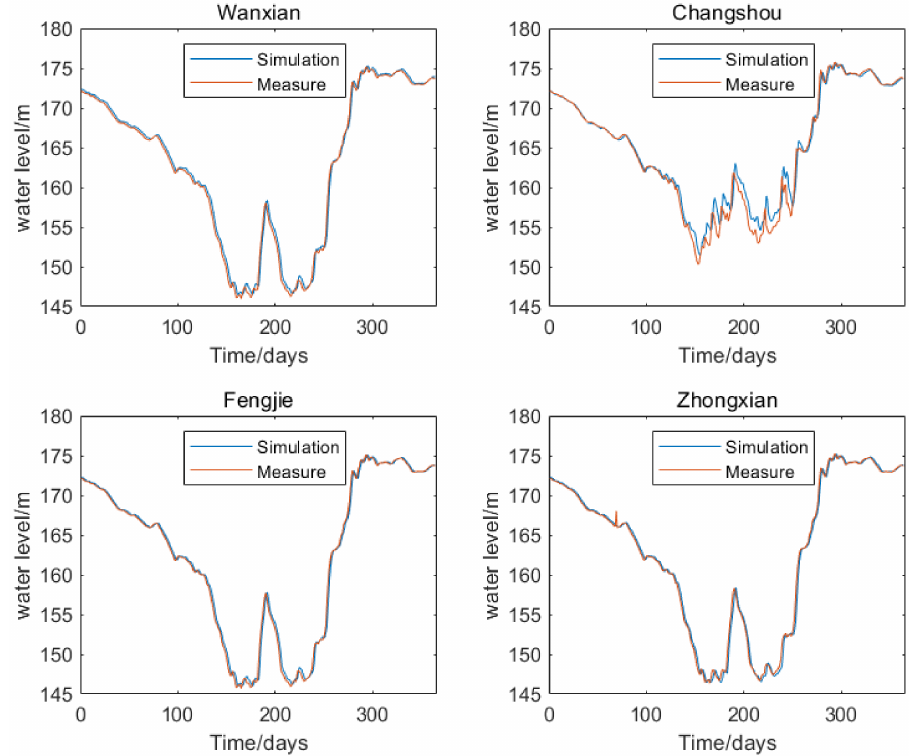
Figure 7. Comparison of the simulation and measured results during the verification period for each hydrological